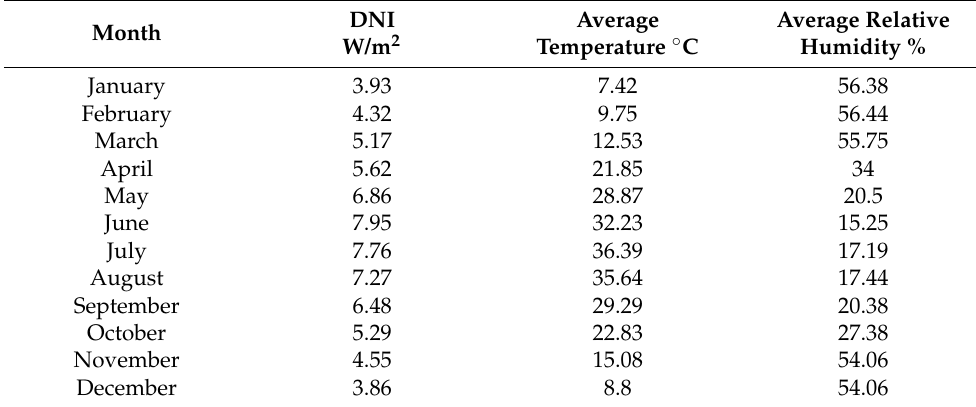
Table 3. Atmospheric properties at the inlet of the air